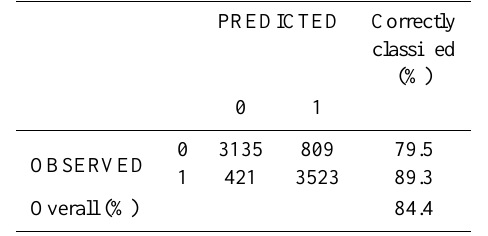
Table 1. Confusion matrix with validation sample constituted by the 25% of the overall sample (0: absence of phenomenon; 1: pres- ence of phenomenon, cut-off value: 0.5).